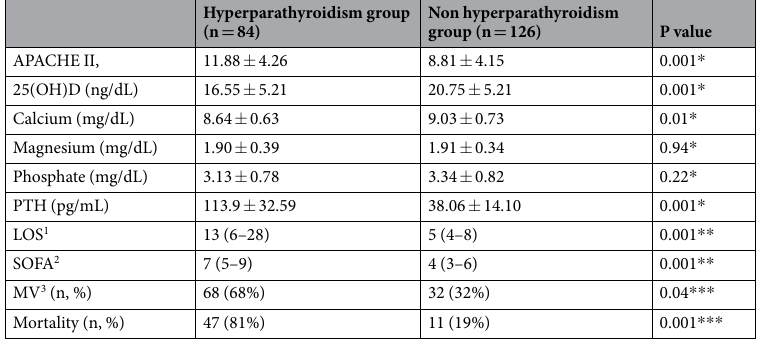
Table 3. Characteristics of patients based on serum PTH. * T test (mean ± SD), ** Man-Whitney (median,